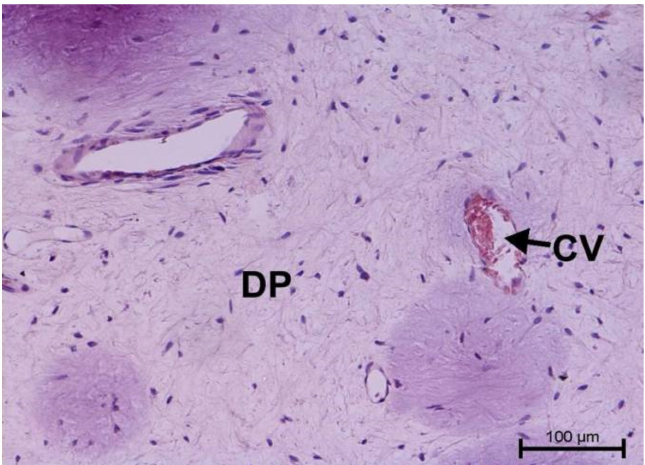
Figure 1. Light microscope image, human molar—Group I. Dental pulp with blood vessels. DP— dental pulp, CV—capillary vessel. HE stain. Mag. 200 × .